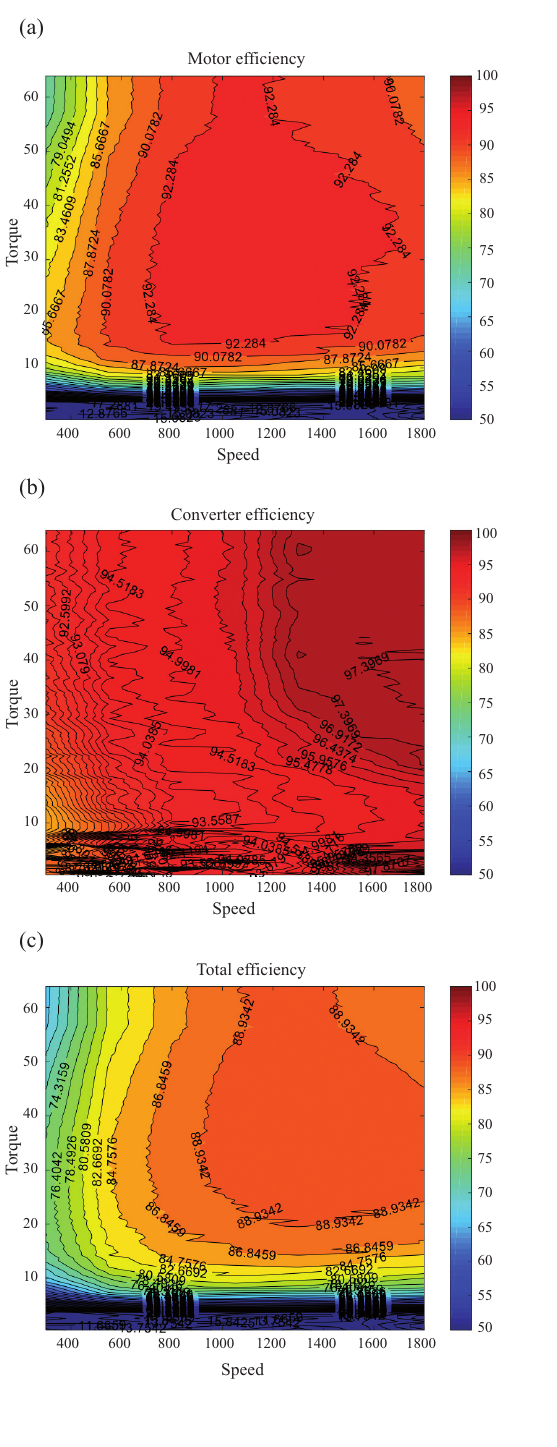
Fig. 5. Efficiency maps of the studied IM (a), feeding IM frequency converter (b), and the whole IM motor­drive system